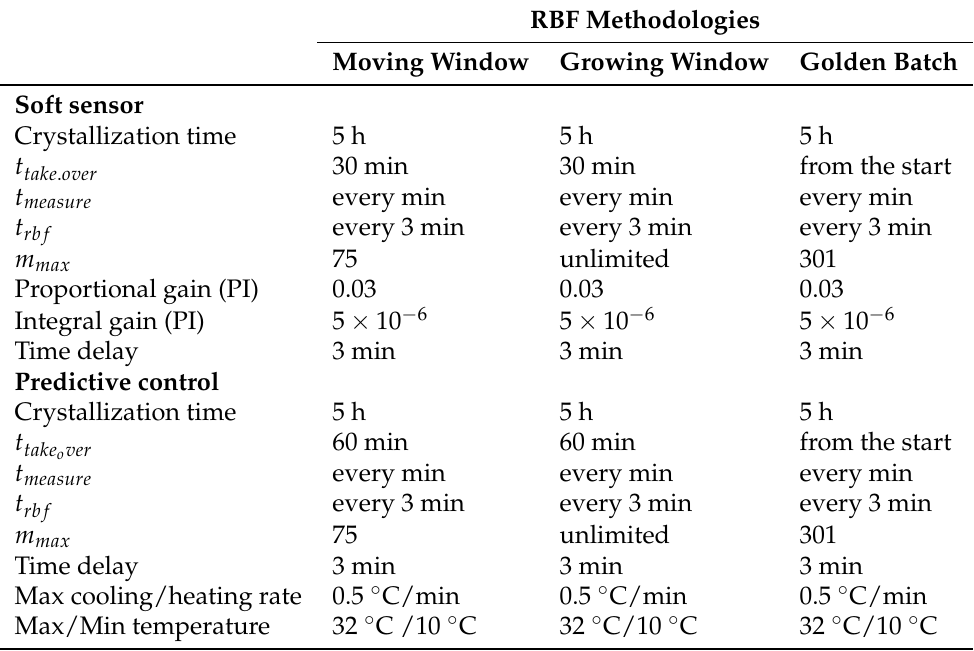
Table 2. Assumptions and conditions of the crystallization for the RBF soft sensor and predictive control